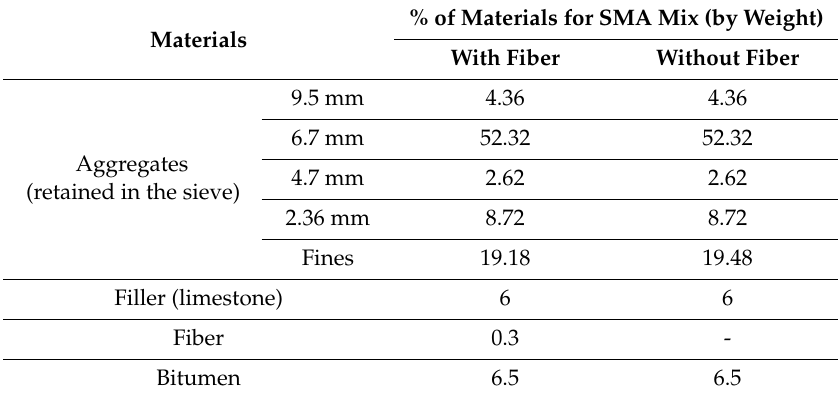
Table 7. Materials used for the preparation of stone mastic asphalt (SMA) for binder drain off test. Materials